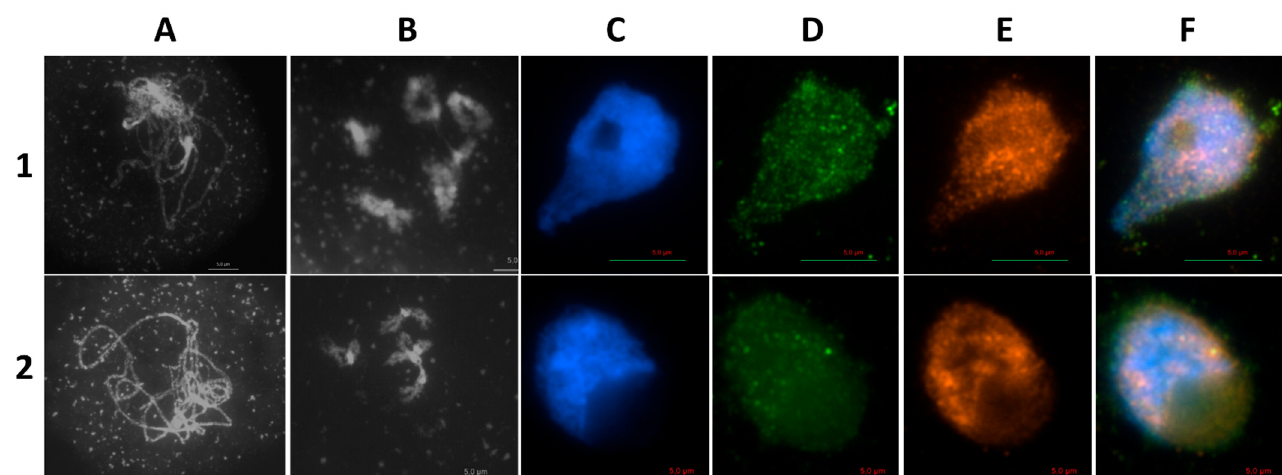
Figure 9. DAPI images and dual immunolocalization study of ASY1 and RAD51: Male meiotic chromosomes counterstained with DAPI during pachytene ( A ) and diplotene ( B ) stages of prophase I in wild-type ( 1 ) and homozygous spo11-1-3-CpaSPO1c Line 4 ( 2 ). Meiocytes were counterstained with DAPI ( C ) and dual immunolocalization of RAD51 ( D ) and ASY1 (E) was performed, single channel pictures were merged afterwards ( F ). Rabbit polyclonal IGg antibody against ASY1 and rat polyclonal IGg antibody against RAD51 was used. Bar = 5 µm.